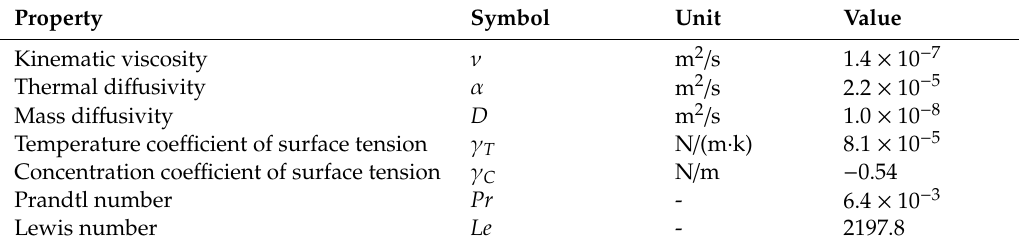
Table 1. Physical properties of silicon-germanium mixture.